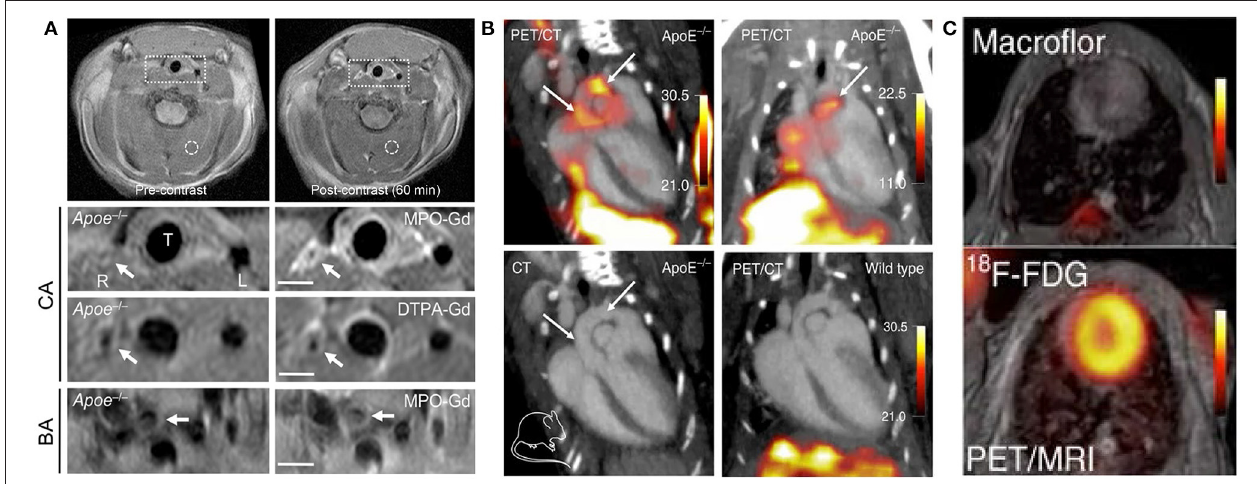
FIGURE 3 | Examples of MRI and nuclear imaging for macrophages in atherosclerosis. (A) Pre- and post-MPO-Gd and DTPA-Gd T1-TSE imaging in TS Apoe − / − mice. Representative as-acquired (2-cm field-of-view) MR images and higher-magnification images of unstable plaque (R), plaque-free artery (L) and stable plaque (BA) before and 60min after probe administration, with corresponding time-course of CNR (MPO-Gd, filled symbols; DTPA-Gd, open symbols) in L (squares), R (circles), and BA (triangles) [adapted from ( 53)]. (B) Representative PET/CT images of several experiments in ApoE − / − and wild-type control mice after IV Macroflor injection. (C) Cardiac PET images with respective agents (above: Macroflor, below: [18F] FDG) [adapted from